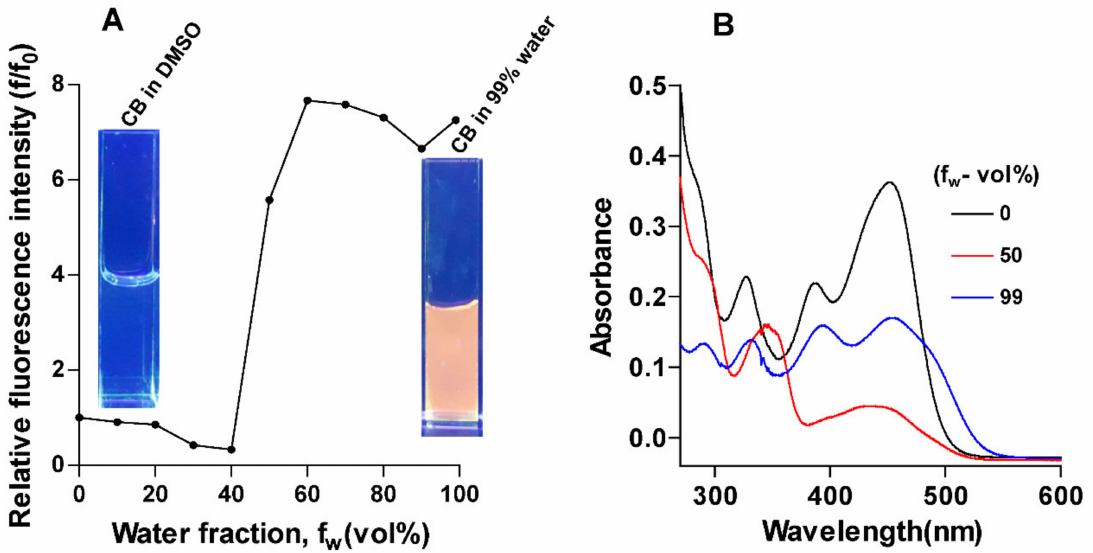
Figure 3. Absorbance and fluorescence properties of CB. ( A ) Plot showing the variation in relative fluorescence intensity (f/f 0 ) with respect to water fraction, f w (vol %), for Figure 2B. f represents the total fluorescence calculated for each f w fraction and f 0 is the value that of f w corresponds to 0%. ( A ) Photographs of CB (10 µ M) in water–DMSO (left corner f w = 0% and right corner f w = 99%) visualized under UV irradiation. ( B ) UV–vis absorption spectra of CB (10 µ M) for f w = 0, 50, and